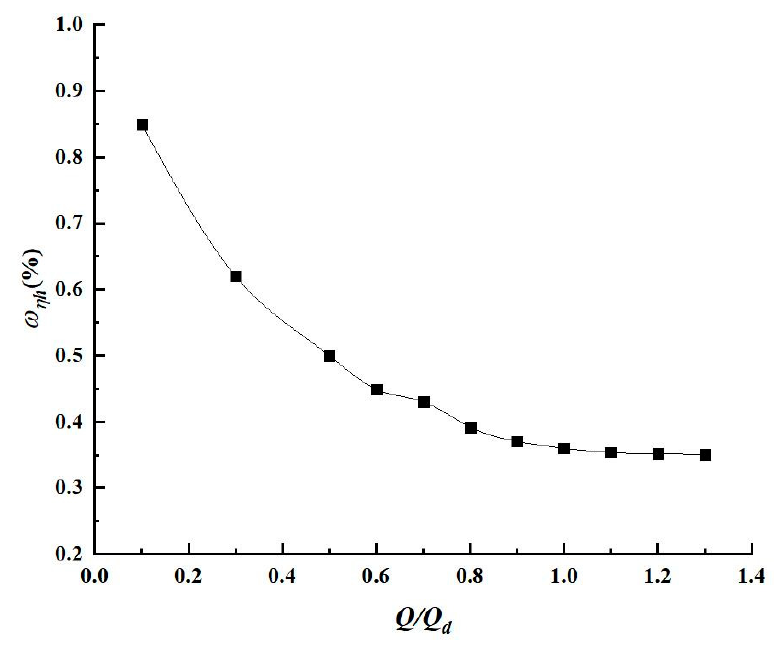
Figure 4. Variation of uncertainty value with flow rate.